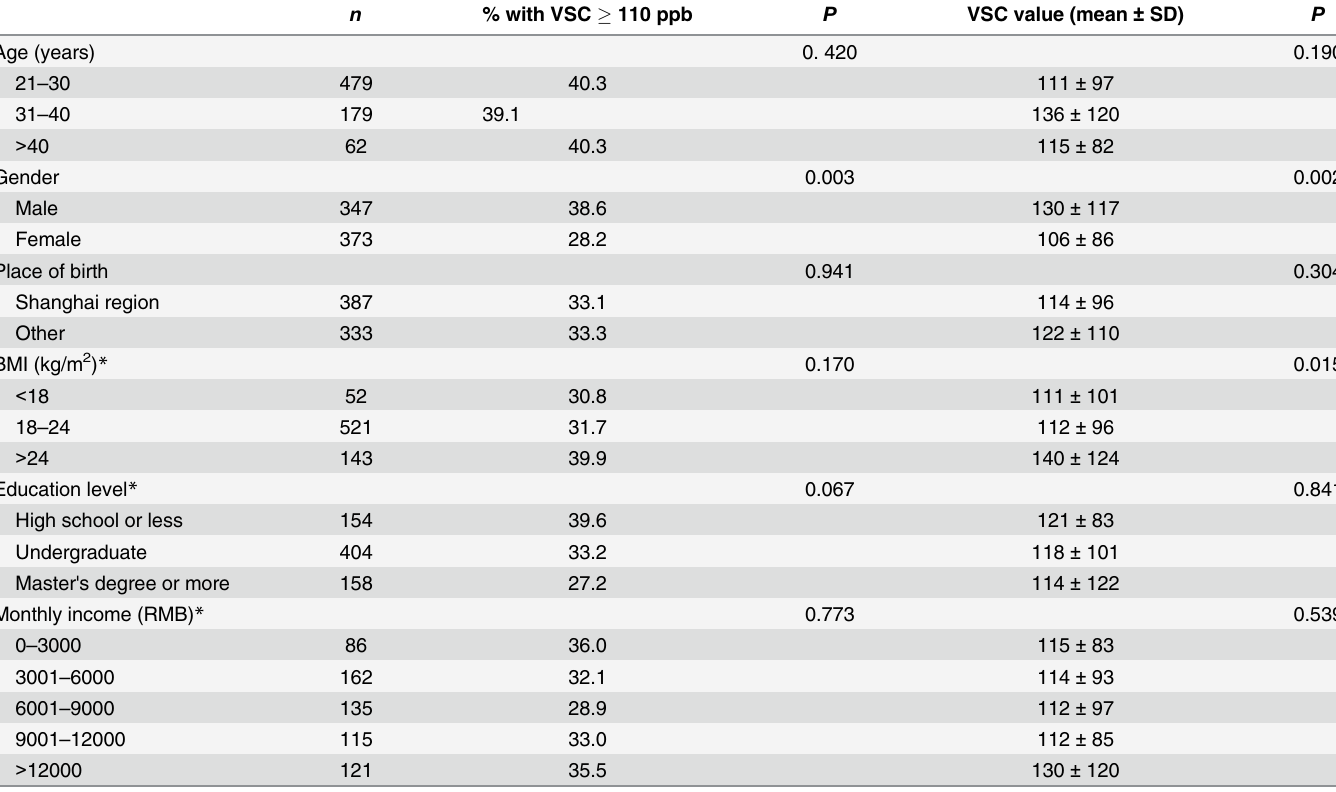
Table 1. Relationships between oral malodor measurements and sociodemographic and background characteristics of white-collar employees in China #